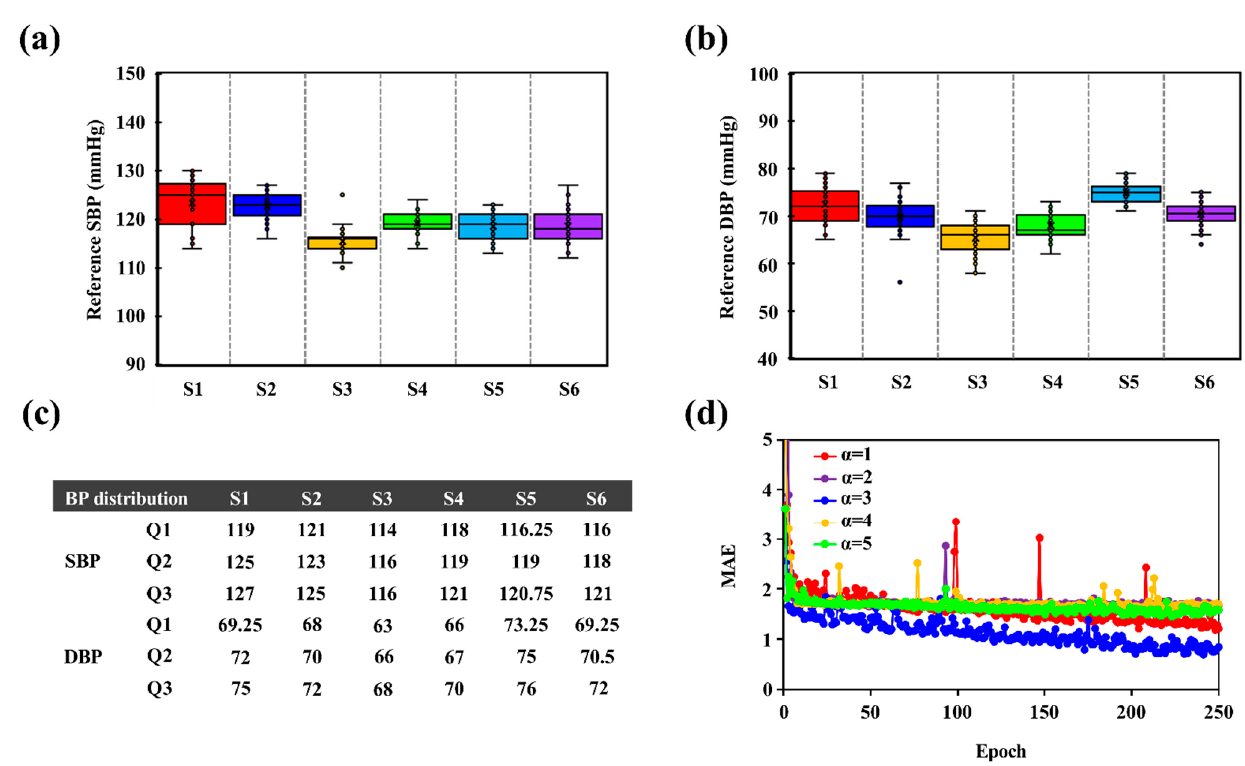
Figure 4. ( a ) Reference SBP and ( b ) DBP distribution for six participants. ( c ) Statistical BP results in quartiles 1, 2, and 3 within six subjects. ( d ) Performance evaluation of model convergence for the penalty terms with different weighting in the interval below quartile 1 and above quartile 3.